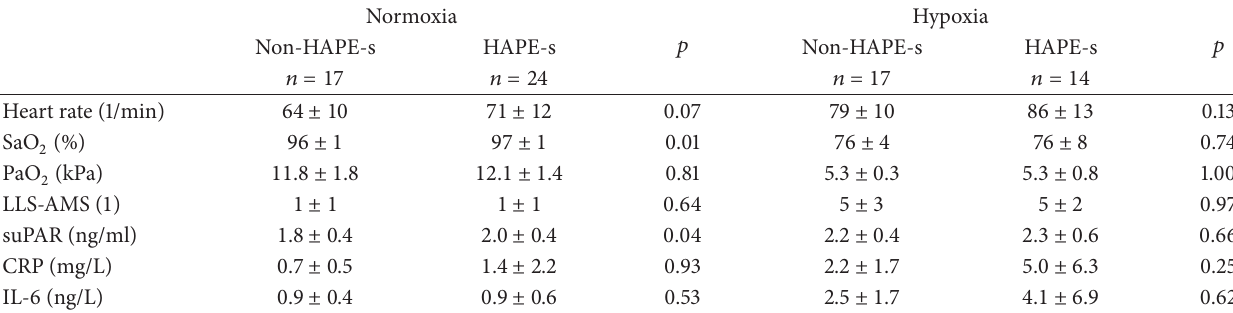
Table 2: Inflammatory markers and physiologic parameters of HAPE-susceptible and non-HAPE-susceptible persons at sea level (normoxia) and during acute hypoxic exposure.